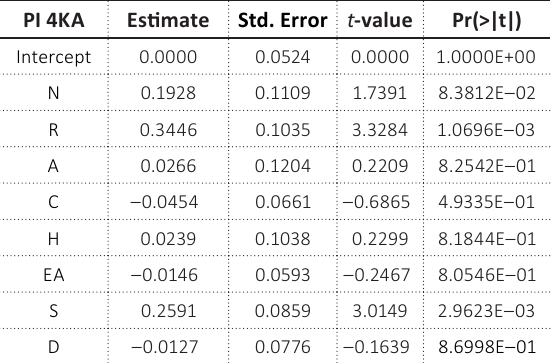
Table 5. PLS PM model output – whole